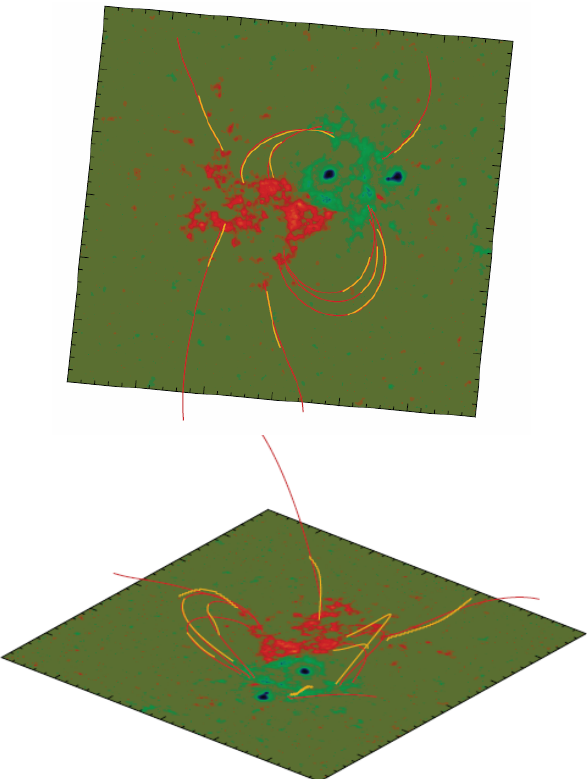
Fig. 5. Stereoscopic reconstructed 3D loops and sections of loops (yellow) and best fit linear force-free field lines (red) from differ- ent viewpoints (top panel: view from STEREO-A, bottom panel: Northeast of the Active Region). [Original published in (Feng et al., 2007a), figure 3 and 4.]